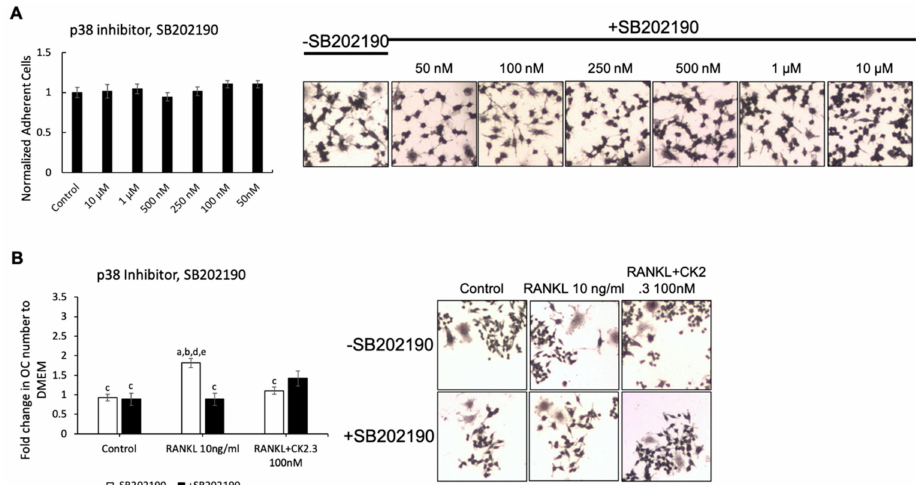
Figure 4. p38 inhibitor, SB202190, did not a ff ect the antagonistic e ff ect of CK2.3 on RANKL-induced osteoclastogenesis. ( A ) Concentration curve for SB202190 to determine the working concentration. ( B ) The e ff ect of SB202190 on the antagonistic e ff ect of CK2.3 on RANKL-induced osteoclastogenesis. a: denotes significant di ff erence from Control without inhibitor, b: denotes significant di ff erence from Control with inhibitor, c: denotes significant di ff erence from RANKL at 10 ng / mL without inhibitor, d: denotes significant di ff erence from RANKL at 10 ng / mL with inhibitor, and e: denotes significant di ff erence from RANKL + CK2.3 at 100 nM without inhibitor.